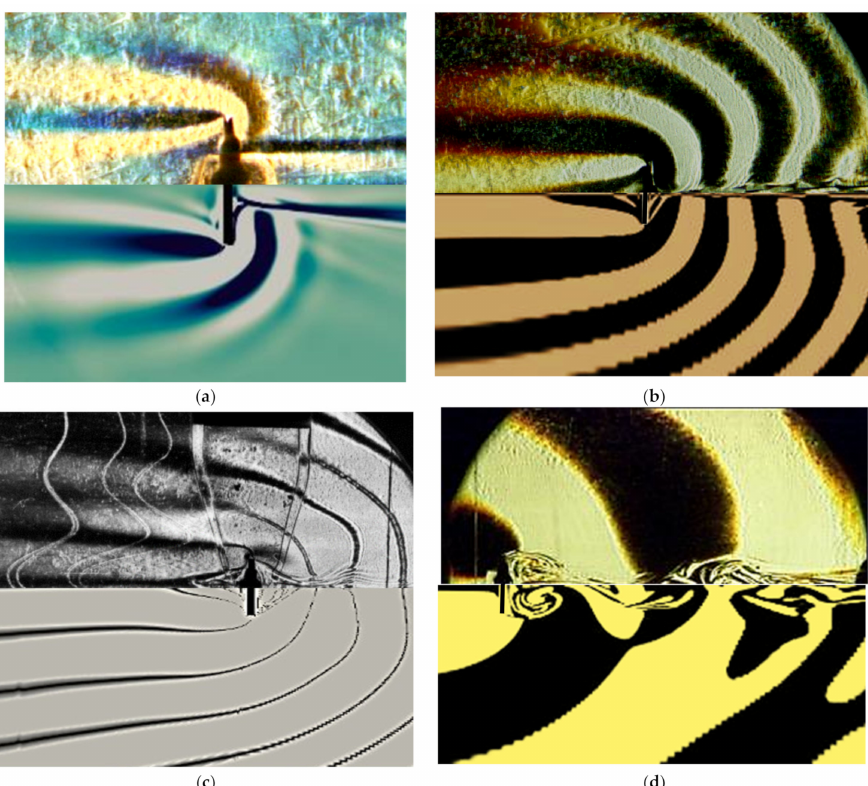
Figure 8. Schlieren (upper part of the images) and calculated (lower one) stratified flow patterns around a uniformly moving vertical plate: ( a – d ) T b = 12.6 s, L = 2.5 cm, U = 0.03,0.18,0.26,0.75 cm/s, thin wavy lines in the Schlieren images are density markers which visualize the horizontal velocity component profile in the fields of upstream perturbations and attached internal